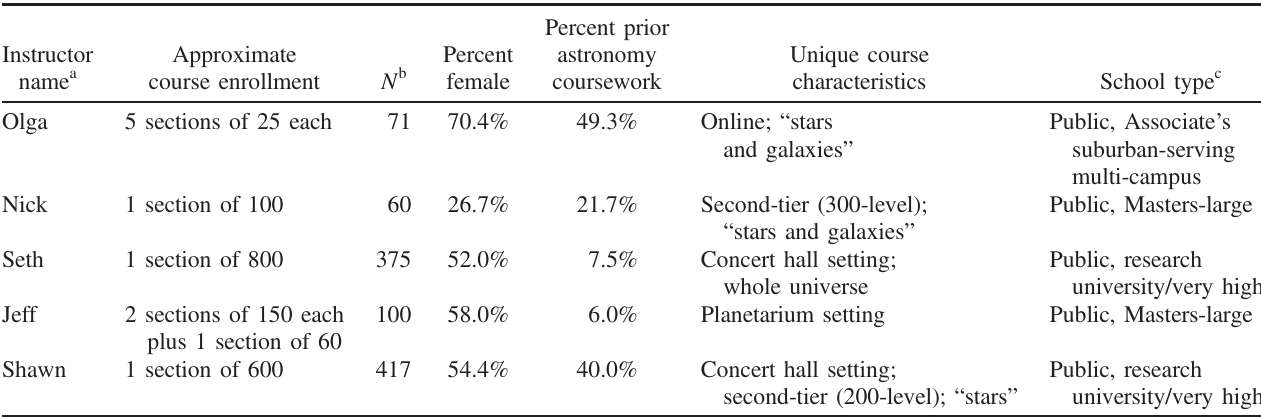
TABLE I. Participating instructor, course, and school characteristics.